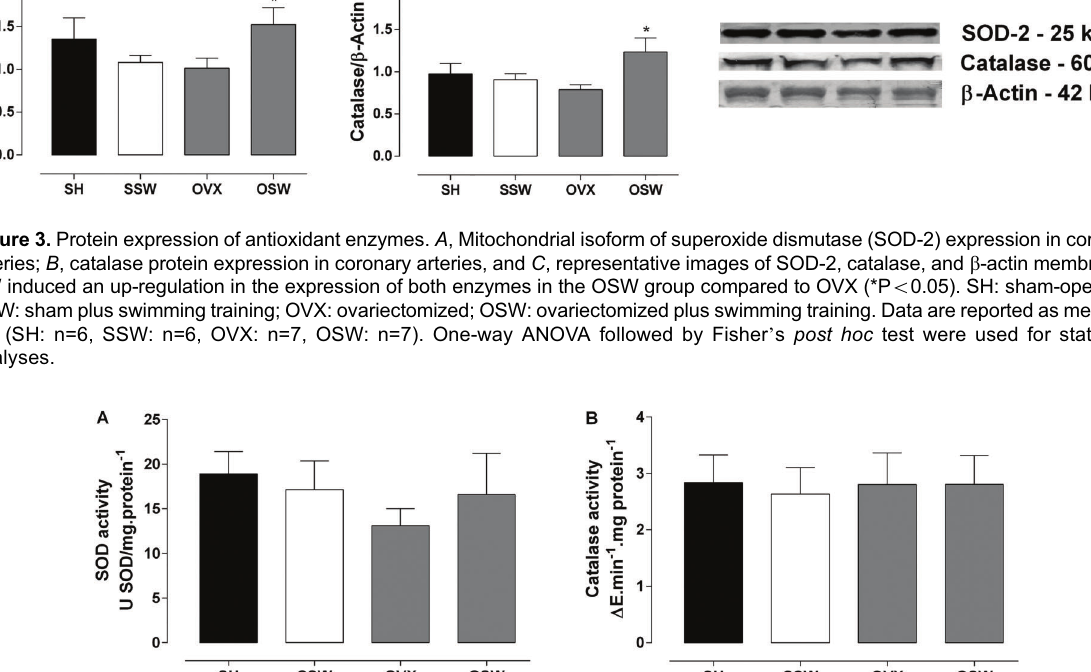
Braz J Med Biol Res | doi: